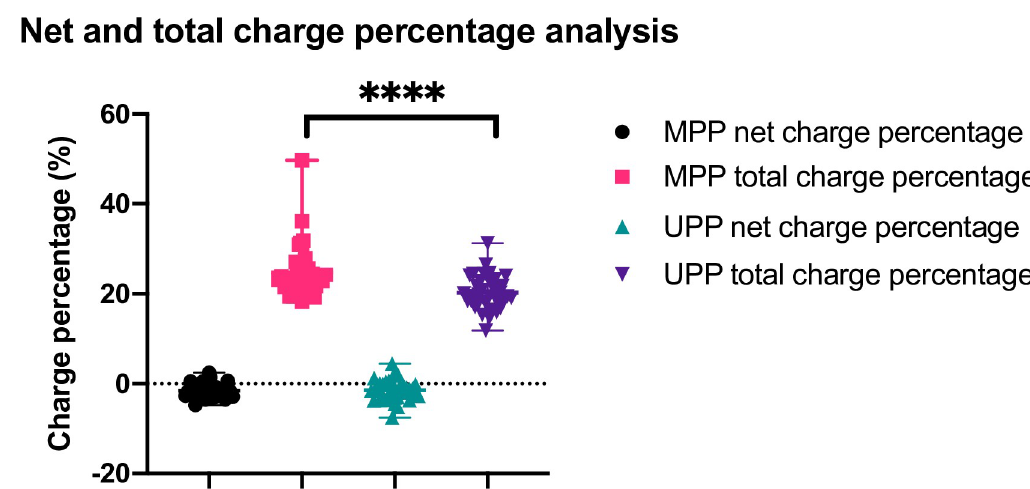
Fig 4. Cluster plots of net charge percentage and total charge percentage comparing the truncated MPP set to UPP. Net charge percentage clusters for both the truncated set of MPP (black circles) and UPP (green triangles) were tightly clustered around 0, as expected, with no difference observed between the mean values. The total charge percentage cluster for MPP data (pink squares) demonstrated a broader distribution extending particularly to higher total charge values with a larger mean value than the UPP data (purple inverted triangles); 25 ± 6% vs 20 ± 4% respectively (p <